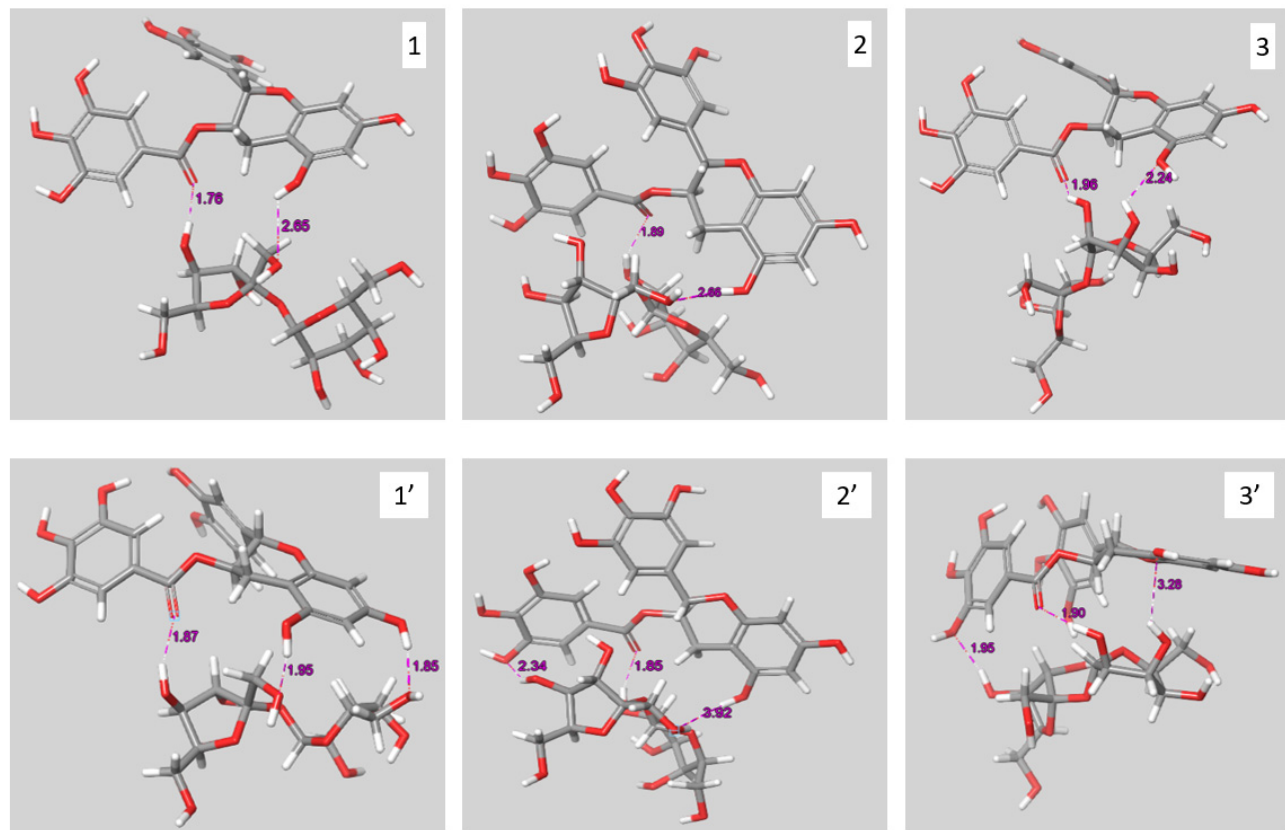
Figure 5. Structures of the initial (1, 2 and 3) and the geometrically optimized complexes (1 ′ , 2 ′ and 3 ′ ).